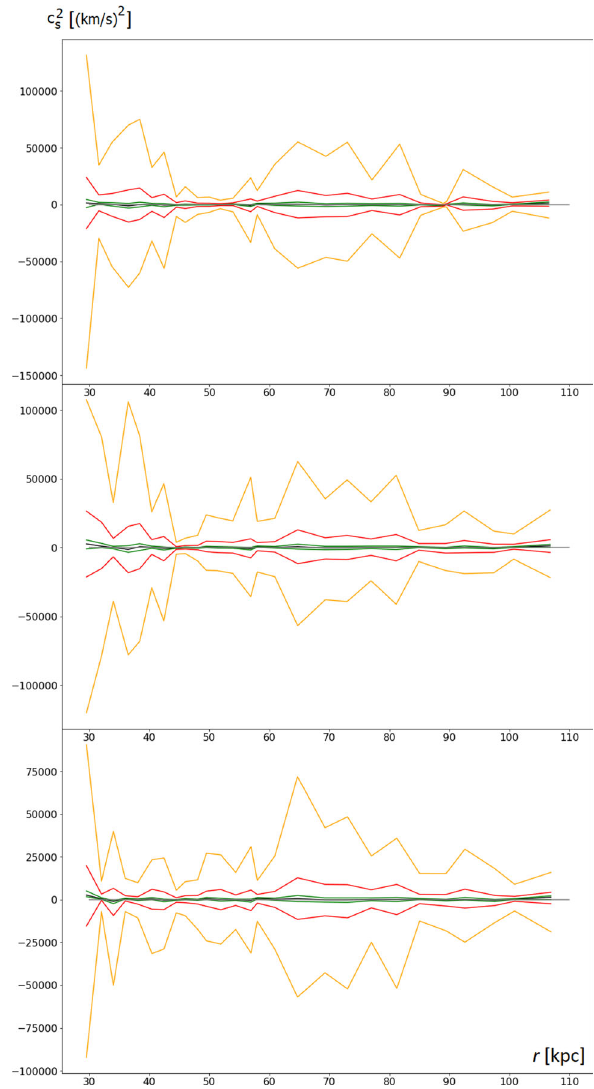
Fig. 5 Median (blackline)andlowerandupperboundsof68% (green lines), 95% (red lines) and 99% (orange lines) confidence intervals of c 2 s calculated using three-point scheme for the calculation of derivatives for three combinations of distance of Sun from the galactic center and Sunorbitalvelocityaroundthegalacticcenter: ( R 0 = 8 . 0kpc, v 0 = 200 km/s) (top), ( R 0 = 8 . 3 kpc, v 0 = 244 km/s) (middle) and ( R 0 = 8 . 5 kpc, v 0 = 220 km/s)